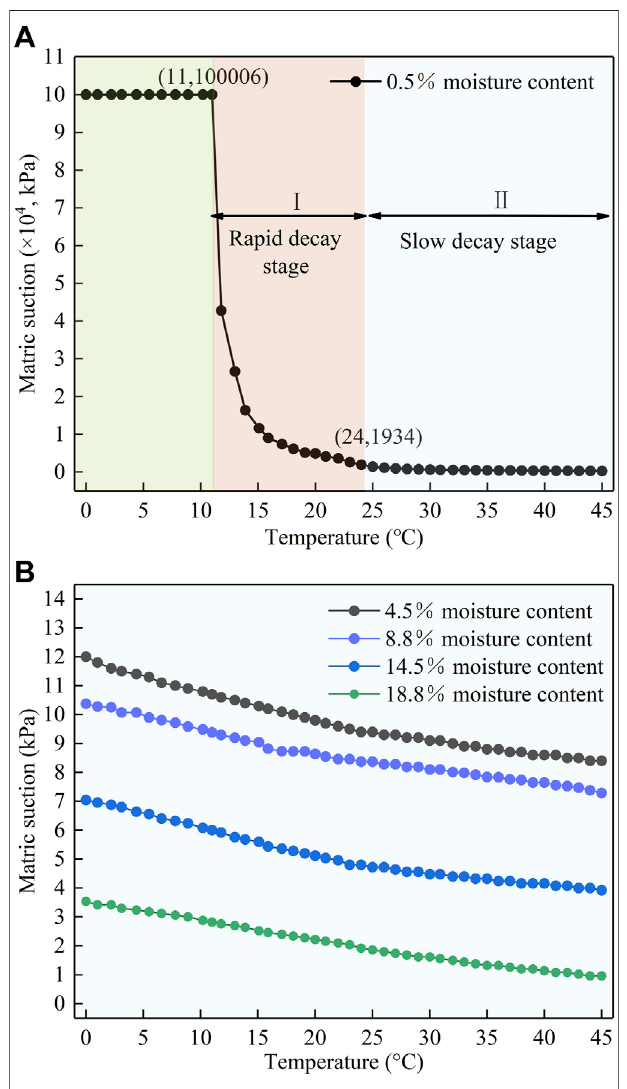
FIGURE 6 | Matric suction for unsaturated sand with different moisture content and temperature. (A) 0.5% moisture content; (B) 5 – 20% moisture content.